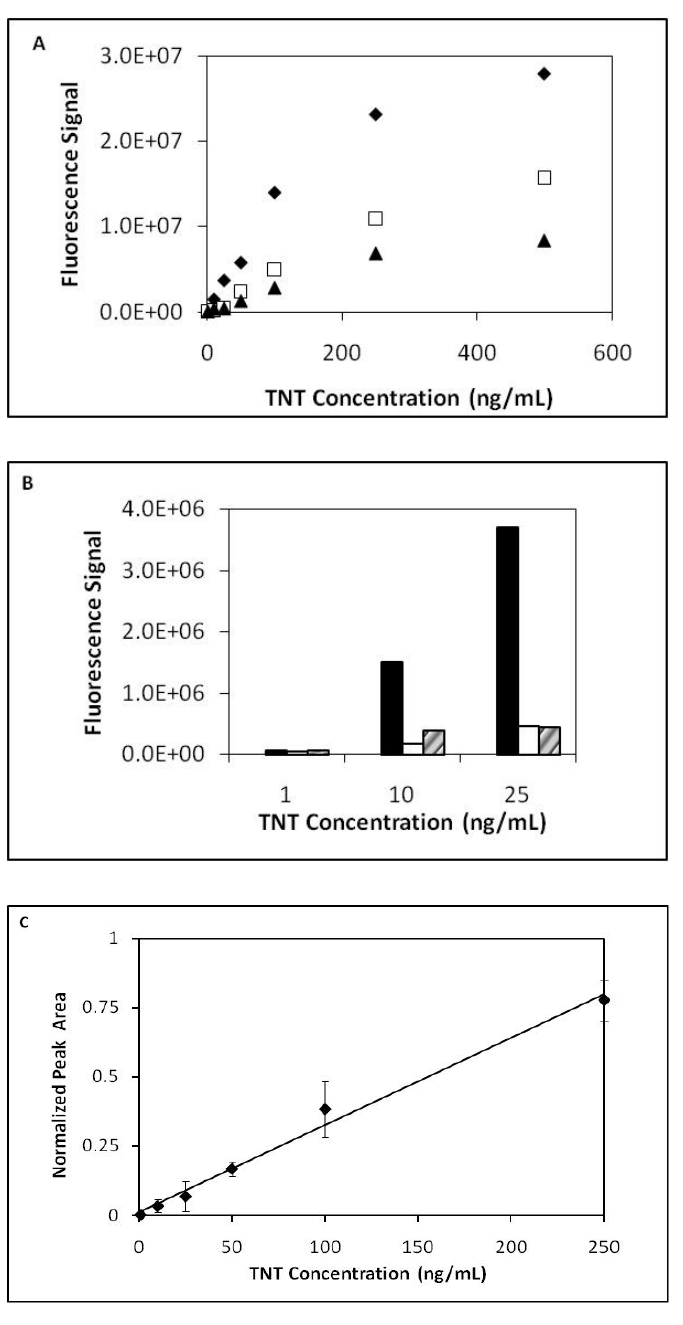
Figure 2. (a) Dose response curves for TNT using a multi-channel PMMA microfluidic device. Series 1 (filled diamonds), Series 2 (open squares) and Series 3 (filled triangles). (b) Bar plot of dose responses for TNT at low concentrations seen in Figure 2a. Series 1 (filled), Series 2 (open) and Series 3 (slanted). (c) Linear plot of normalized data from series 1-3 from TNT concentration 1-250 ng/mL (r 2 = 0.989). SD ±